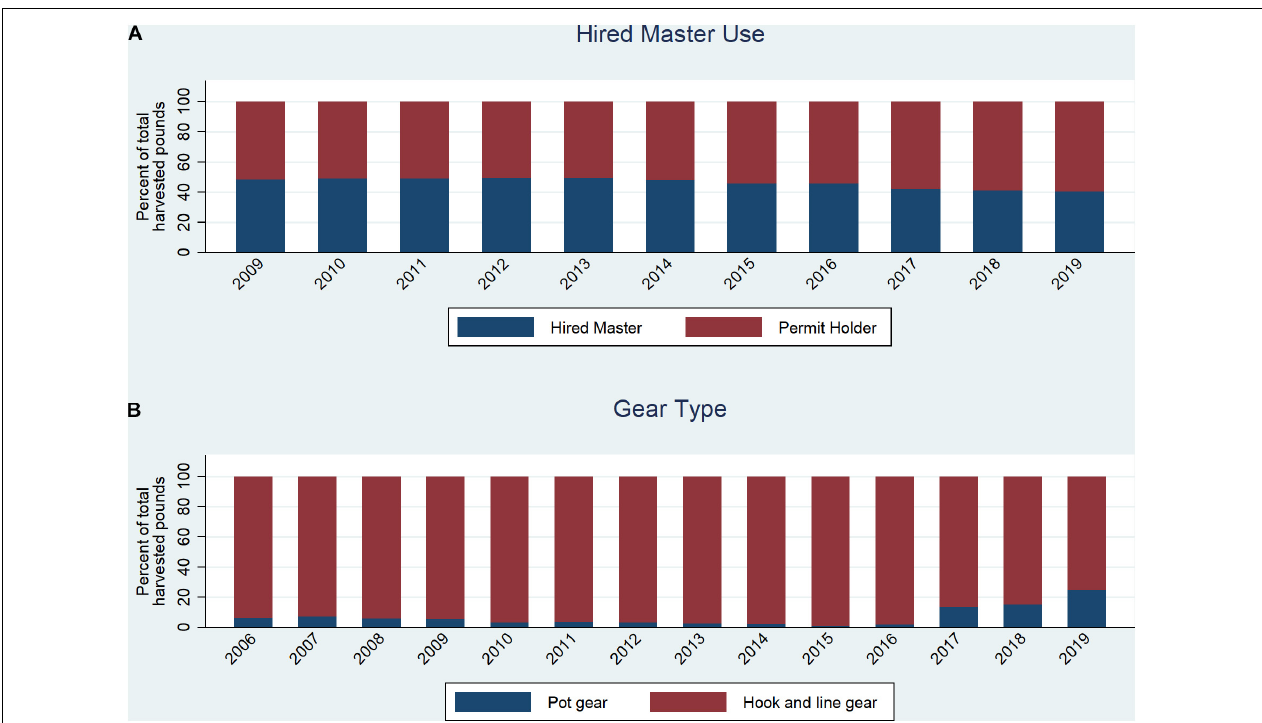
FIGURE 7 | Percent of IFQ sablefish landed by permit holders and hired masters (A) and percent of IFQ sablefish landed by gear type (B)